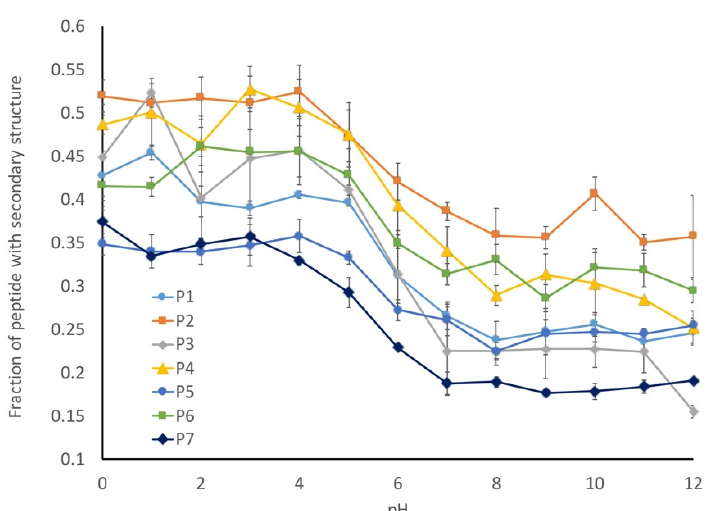
Figure 9. pH-dependence of the fraction of secondary structures for each peptide studied. The amount of secondary structures decreased with the increasing pH, which is consistent with the for- mation of an elongated conformation.